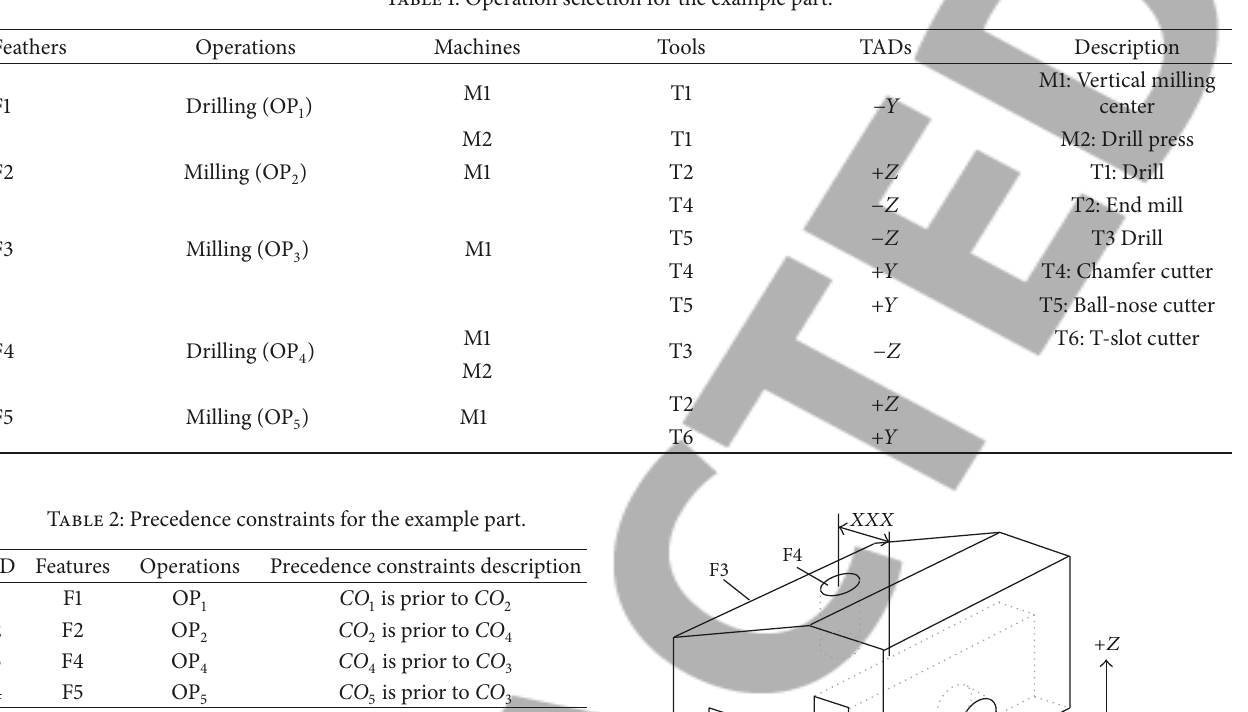
Table 1: Operation selection for the example part.